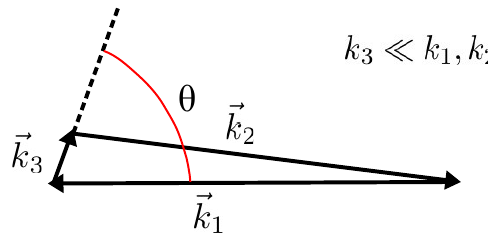
Figure 7 . The squeezed limit of three-point